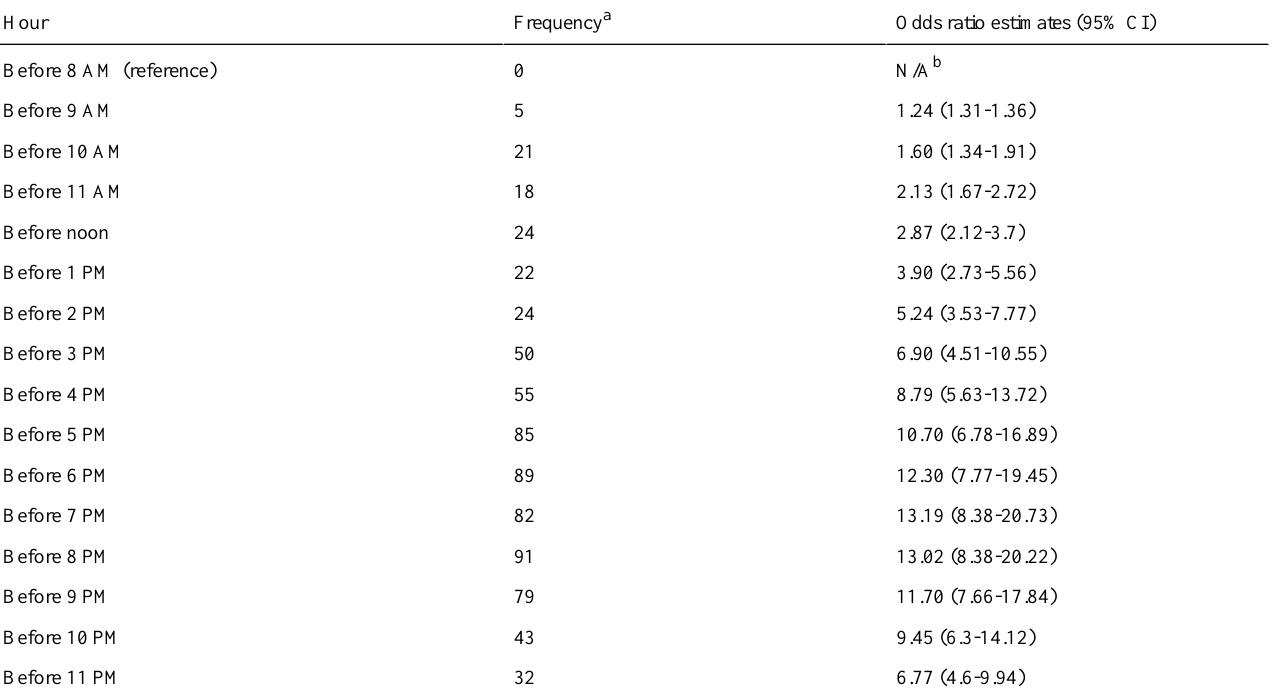
Table 1. Odds ratio estimates of obtaining average moderate-to-vigorous physical activity before hour of day.